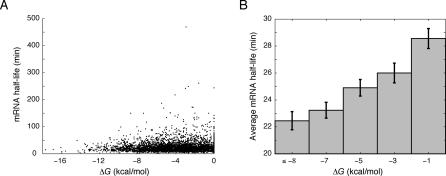
Comparison between mRNA Half-Lives and Folding Free Energies of 5′-UTRs(A) Scatter plot of mRNA half-life and folding free energy of the 5′-UTR (ΔG) for 5,888 ORFs.(B) ORFs were grouped based on the folding free energy (ΔG). For each energy group, the average mRNA half-life (±SEM) is shown. From left to right, the number of ORFs in each energy group used to calculate the average density was 467, 657, 982, 1,169, and 983.